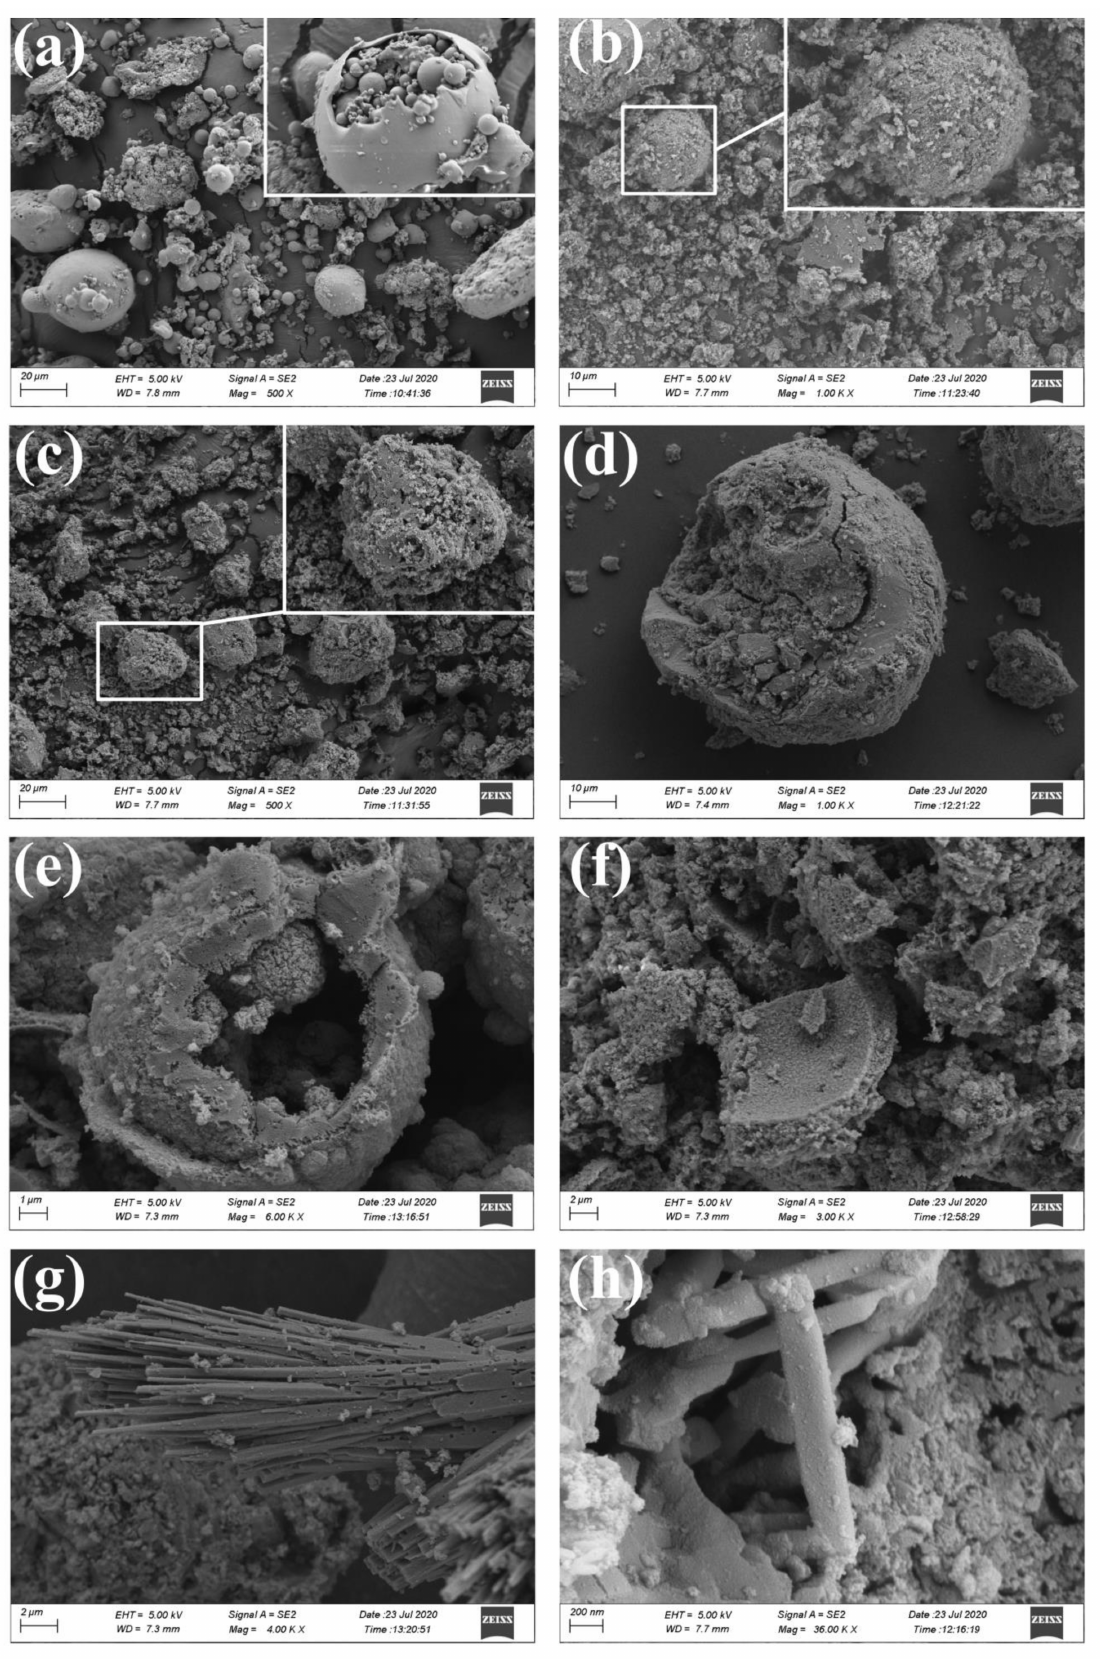
Figure 8. SEM micrographs of the solid samples with variation in calcination time; ( a ) CFA, ( b ) S4-1, ( c ) S4-2, ( d , e ), S4-3, ( f ), S4-4. SEM micrographs of the mullite particles with an acicular structure in sample (S4-4) ( g , h